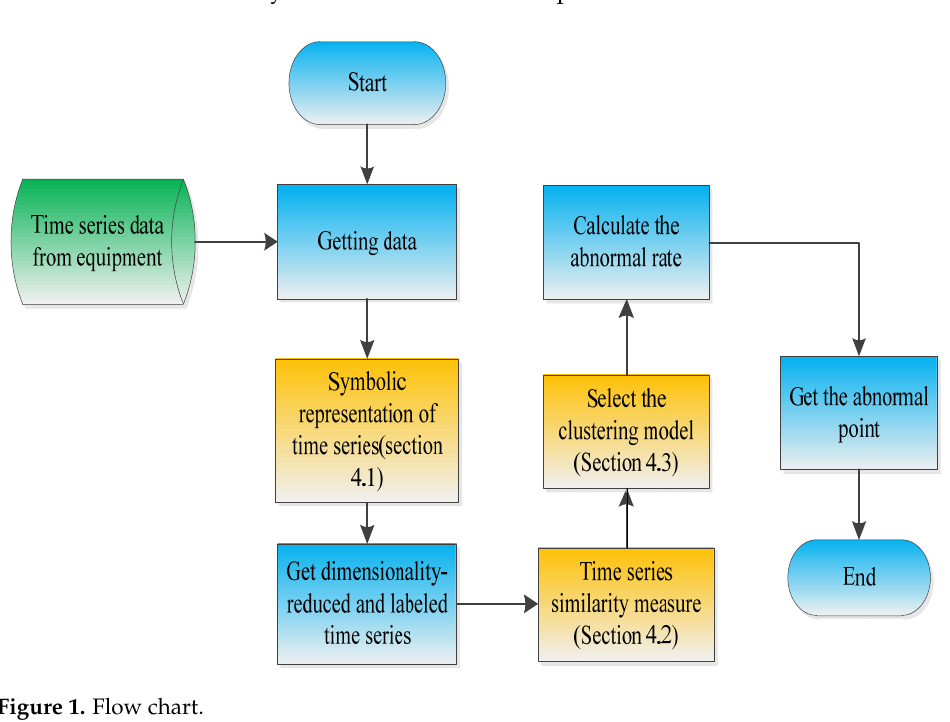
Figure 1. Flow chart.